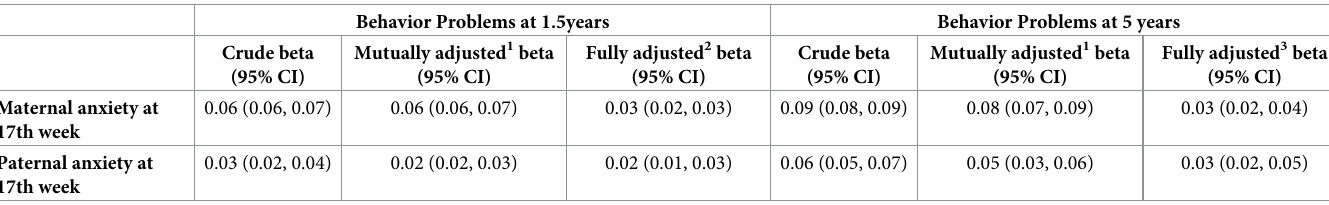
Table 4. The effect of prenatal anxiety on child behavior problems at 1.5 and 5